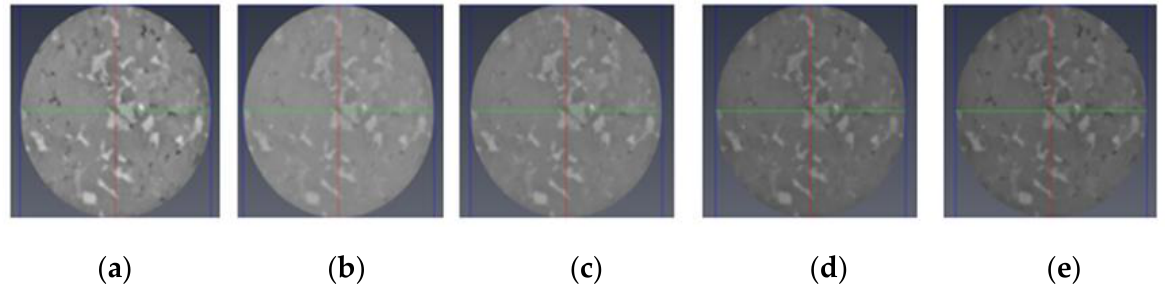
Figure 13. CT scanning results of the Y53 – 89 core under different displacement states. ( a ) Dry rock sample. ( b ) Saturated crude oil. ( c ) First water flooding. ( d ) CO 2 flooding. ( e ) Second water flooding.